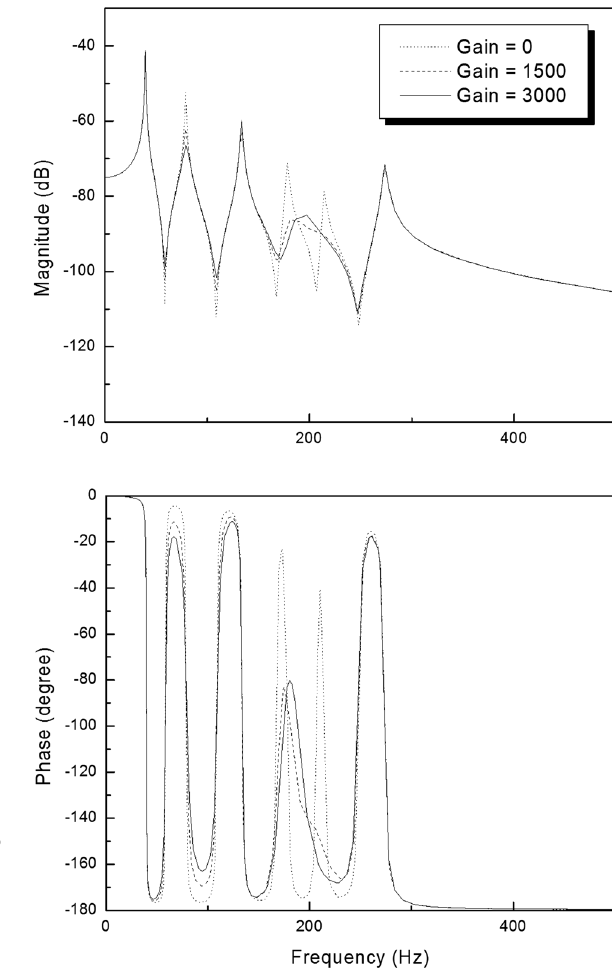
Figure 13: Frequency response of the shear - web case 3 due to a di ff erent feedback control